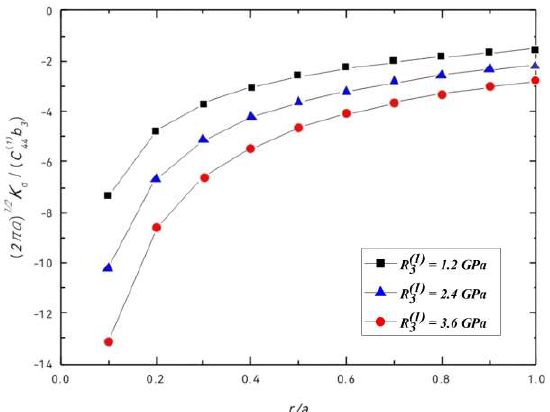
( 1 ) 1/2 K b 3 ) vs. r / a σ / ( C 44